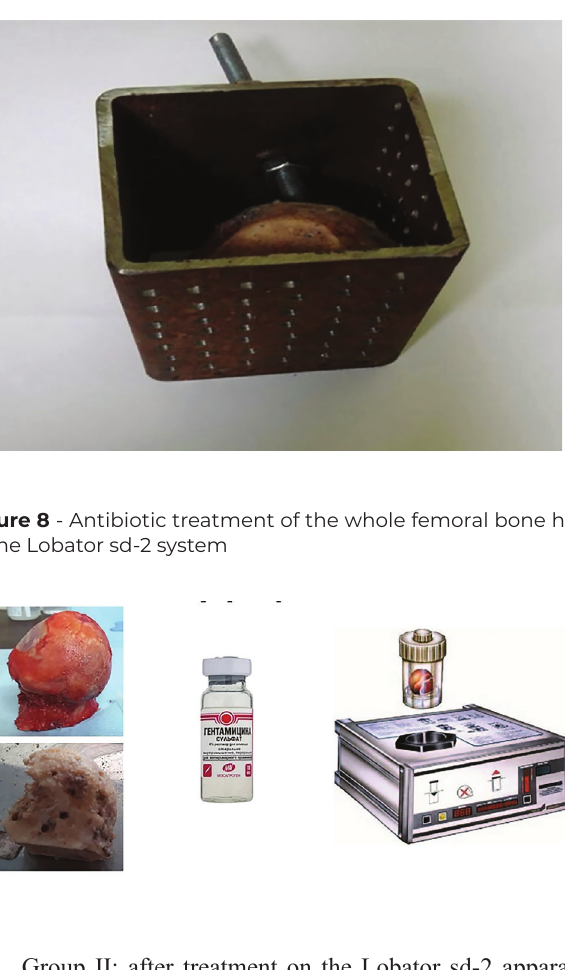
Figure 5 - Top view of a device for bone allograft channeling with subsequent impregnation of drugs into the bone tissue with femoral bone head fixed in it